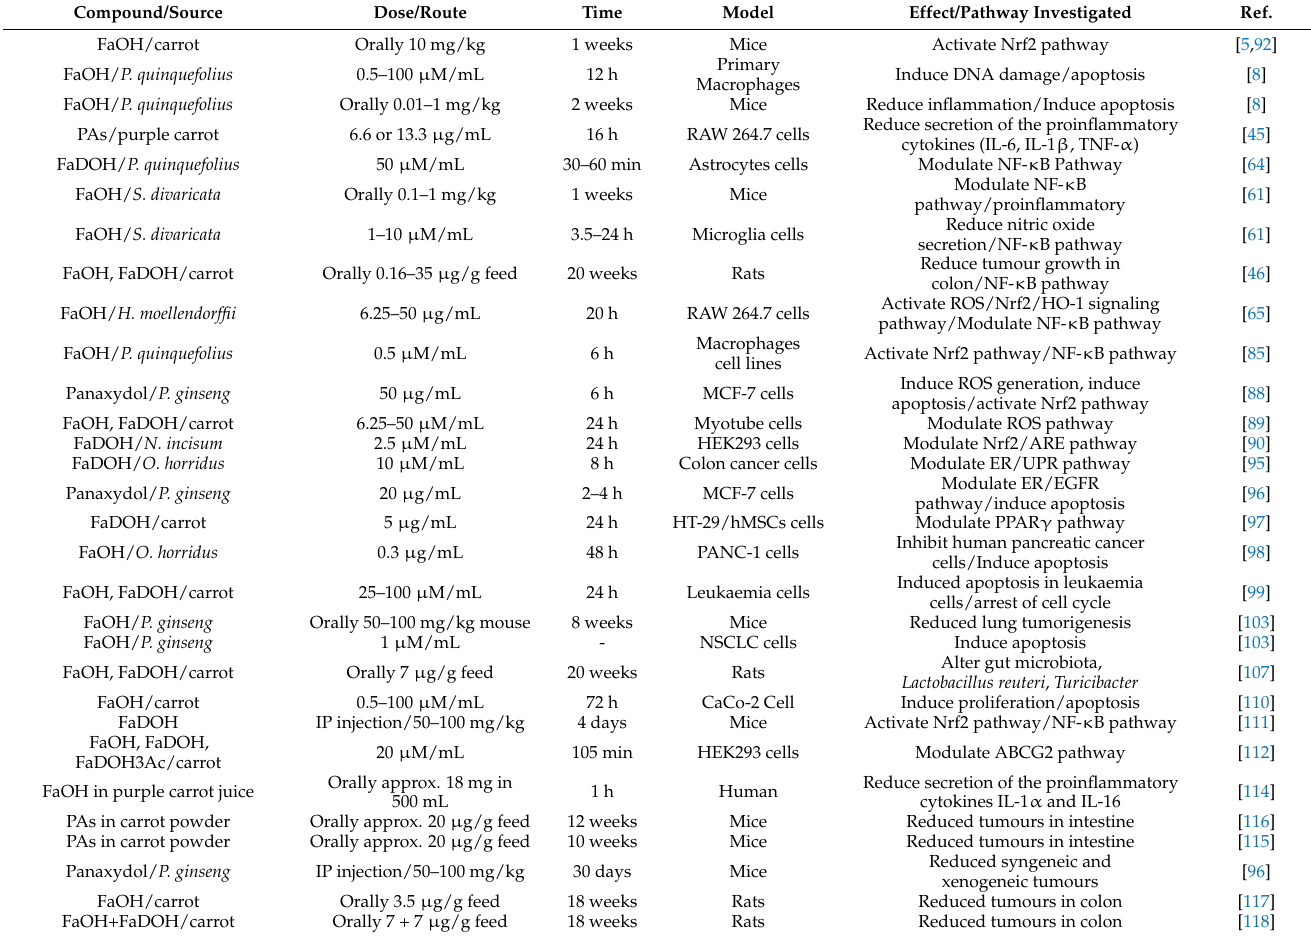
Table 1. Studies of polyacetylene compounds extracted from or contained in natural food and herbs and their applications, doses, time and effect or pathway